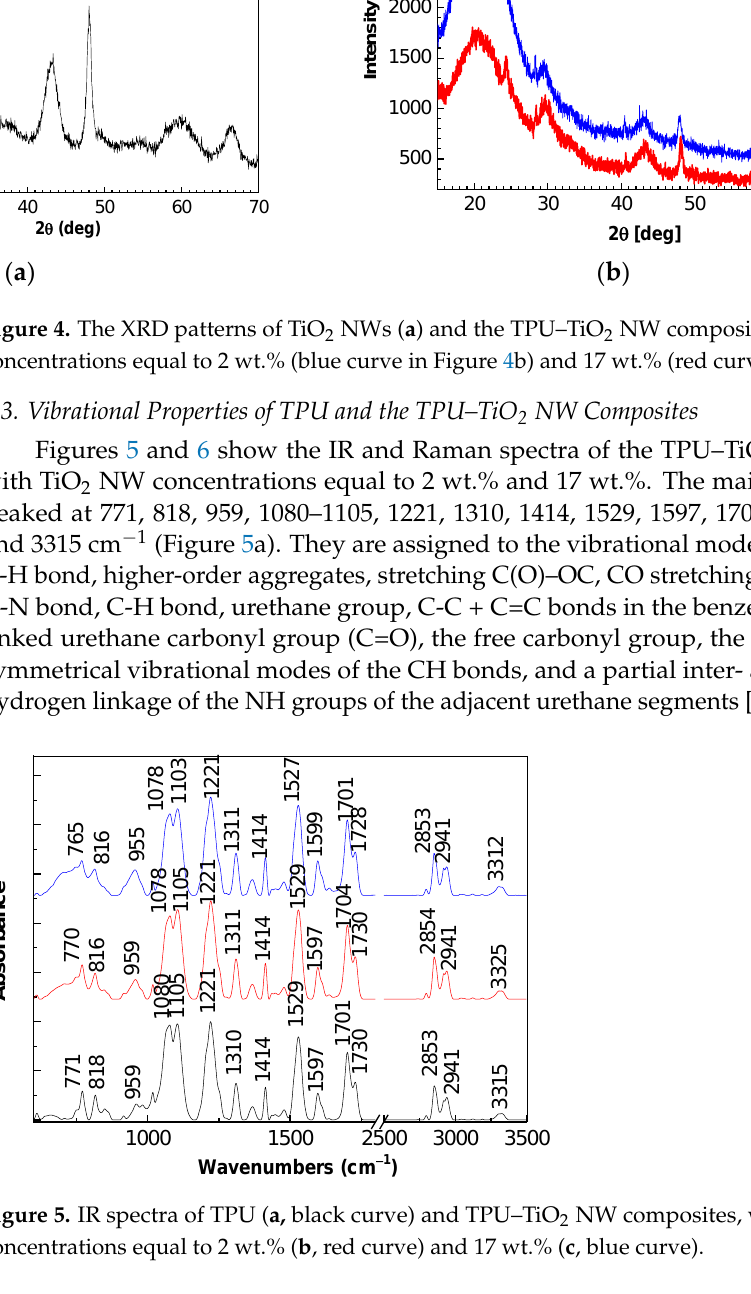
Figure 4b) and 0.96 (red curve in Figure 4b). This decrease in the intensity of the peak at 48–48.3 ◦ can only be explained if an interaction of TiO 2 NWs with PTU occurs, when we estimate that the formation of suboxides takes place. To prove this claim, correlated Raman Figure 4. The XRD patterns of TiO 2 NWs ( a ) and the TPU – TiO 2 NW composites ( b ) with TiO 2 NW scattering and FTIR spectroscopy studies are presented below. concentrations equal to 2 wt.% (blue curve in Figure 4b) and 17 wt.% (red curve in Figure 4b). Compared with Figure 4a, in the case of the TPU – TiO 2 NW composites with TiO 2 NW concentrations equal to 2 wt.% and 17 wt.%, one observes that: (i) the gradual increase in the added TiO 2 NWs is clearly visible at the NWs’ specific 2θ angles; (ii) the peak in the